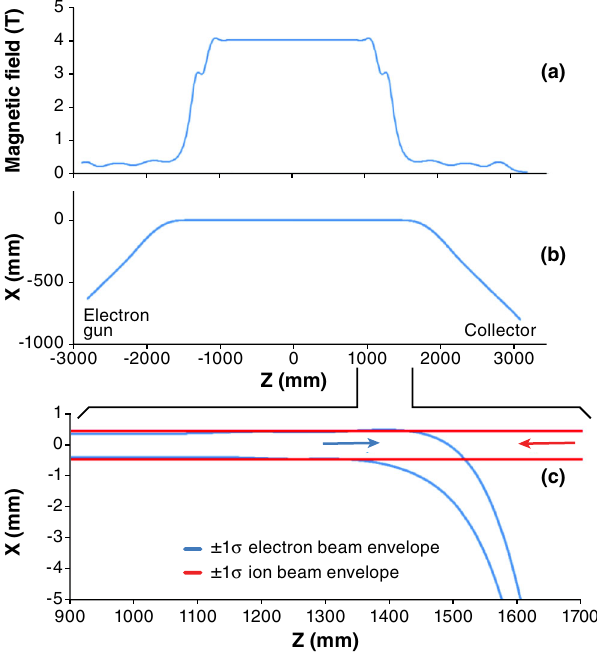
FIG. 18. Magnetic field profile (a) and electron beam trajectory (b) starting at the electron gun and ending at the electron collector. In the magnified view (c) we show the (cid:2) 1 sigma electron beam and ion beam profiles in the region where the electron beam starts curving away on its way to the collector.